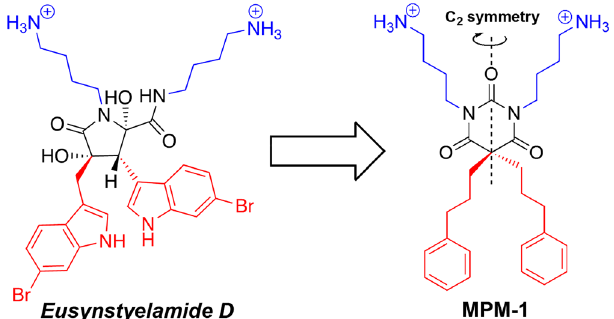
Figure 1. Molecular structures of the marine antimicrobial Eusynstyelamide D and the novel marine natural product mimic MPM-1. Cationic groups are colored blue and lipophilic groups are colored red to highlight the amphipathic arrangement in both